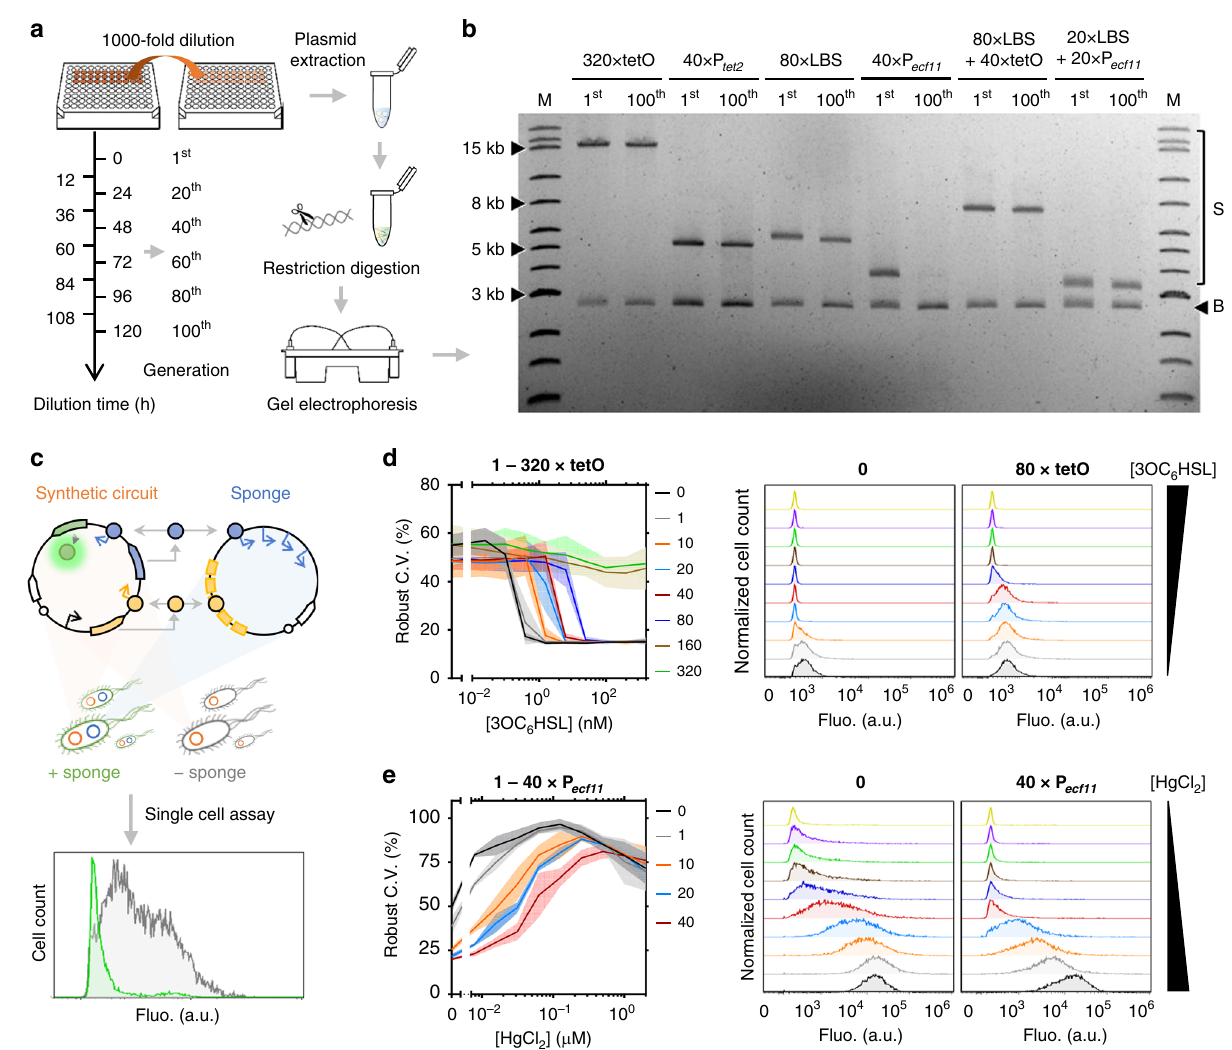
Fig. 6 Genetic stability of synthetic DNA sponge and its effect on circuit ’ s output gene expression noise. a Schematics showing the work fl ow of the stability assay of synthetic DNA sponges. The cells harboring the sponge plasmids were cultured in 1 mL of medium in a 96-deep well plate and were diluted every 12 h for 5 days (corresponding to approximately 100 generations in total). Every 24 h, the cells were harvested for plasmid extraction, restriction digestion and the plasmids were analyzed by electrophoresis (see Methods). b Image of a gel post electrophoresis showing the stability of synthetic single-layer DNA sponges of 320 × tetO, 40 × P tet2 , 80 × LBS, 40 × P ecf11 and dual-layer DNA sponges of 80 × LBS + 40 × tetO and 20 × LBS + 20 × P ecf11 . The sponge plasmids extracted from the host cells after 1 or 100 generations were compared. The plasmids from 20 th , 40 th , 60 th and 80 th generations and another two biological replicates showing similar results are shown in Supplementary Fig. 13. The expected sizes of the selected DNA